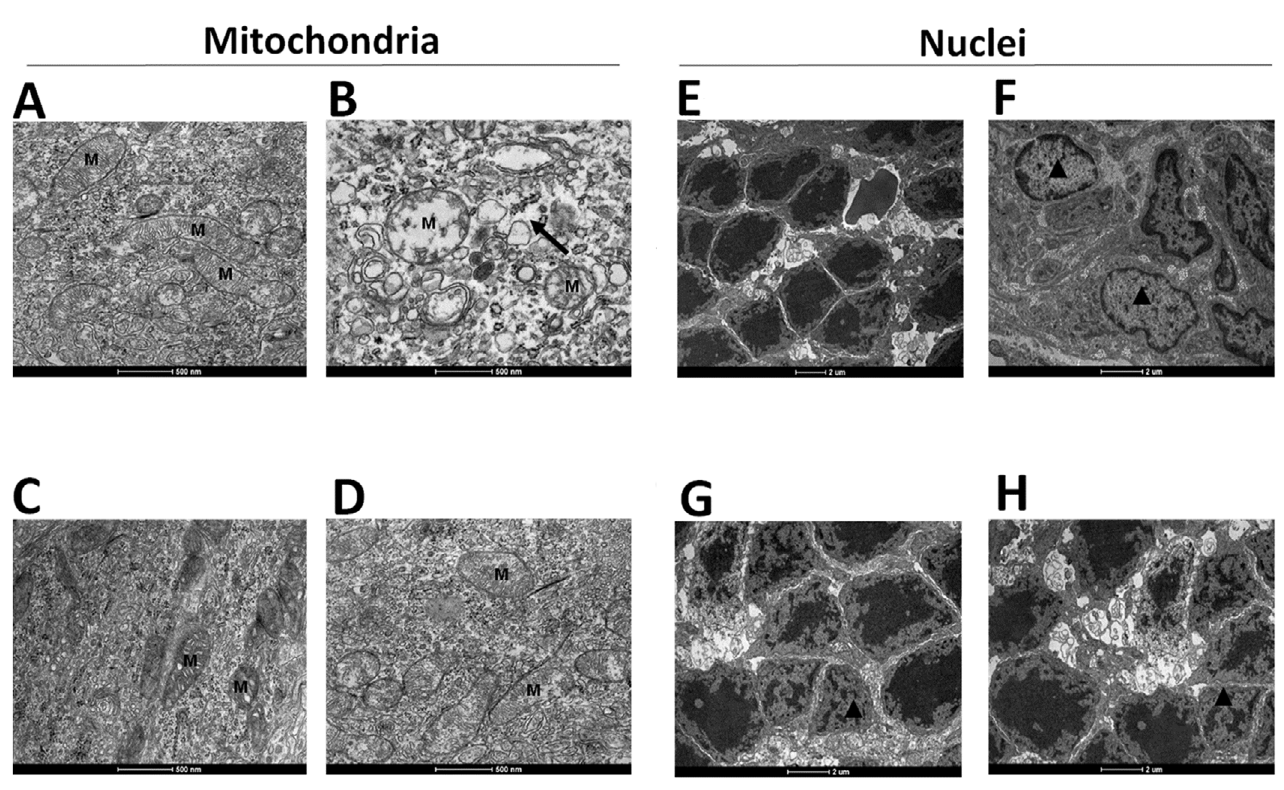
Figure 5. The ultrastructure of the retina after retinal degeneration blue LED-induced. A representative electron micrograph was taken from a healthy retina. The micrograph shows (A) normal appearance of the mitochondria (M) in comparison to (B) micrograph taken from mitochondria after blue LED light exposure that showed cristae fractured and vanished (M) and vacuolar degeneration (black arrow). In the retina that received (C) PnPa11 (1.25 µg/mL) or (D) PnPa13 (1.25 µg/mL) before light exposure, the mitochondria (M) showed a micrograph more preserved. In (E) note the photoreceptor nuclei in the ONL healthy retina, while in (F) nucleus pyknosis (▲) are seen after blue LED light exposure. Photoreceptors nuclei in the ONL show relatively normal nuclear appearance in the retina that received (G) PnPa11 (1.25 µg/mL) or (H) PnPa13 (1.25 µg/mL) prior to light